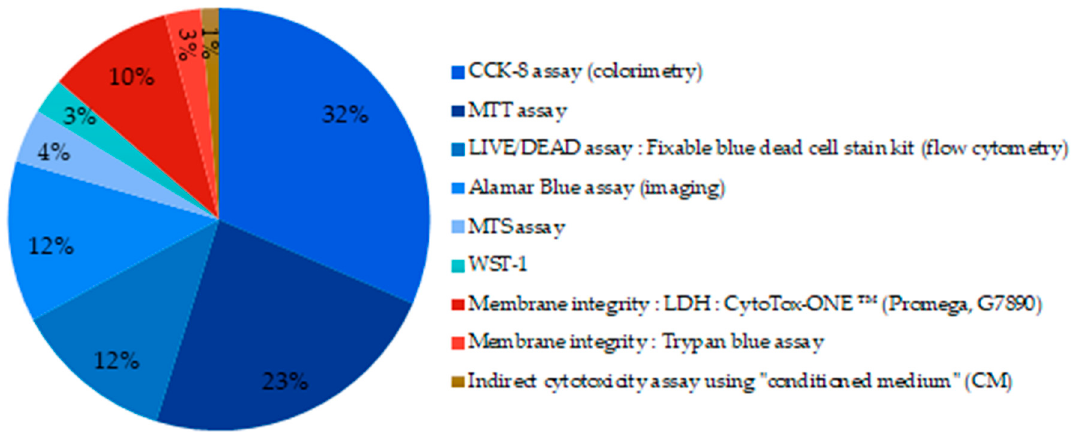
Figure 9. Techniques used to assess cell viability of MBGs. (blue part: metabolic assays; red part: membrane integrity